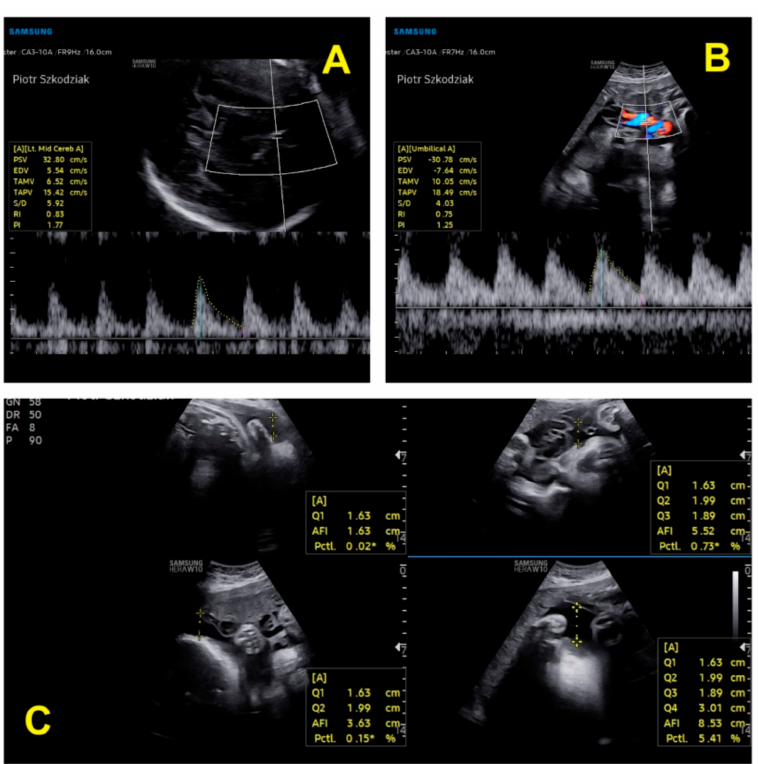
Figure 4. Ultrasound parameters of the second twin’s well-being: ( A ) assessment of blood flow in the MCA; ( B ) assessment of blood flow in the UA; ( C ) amniotic fluid index [6,7].